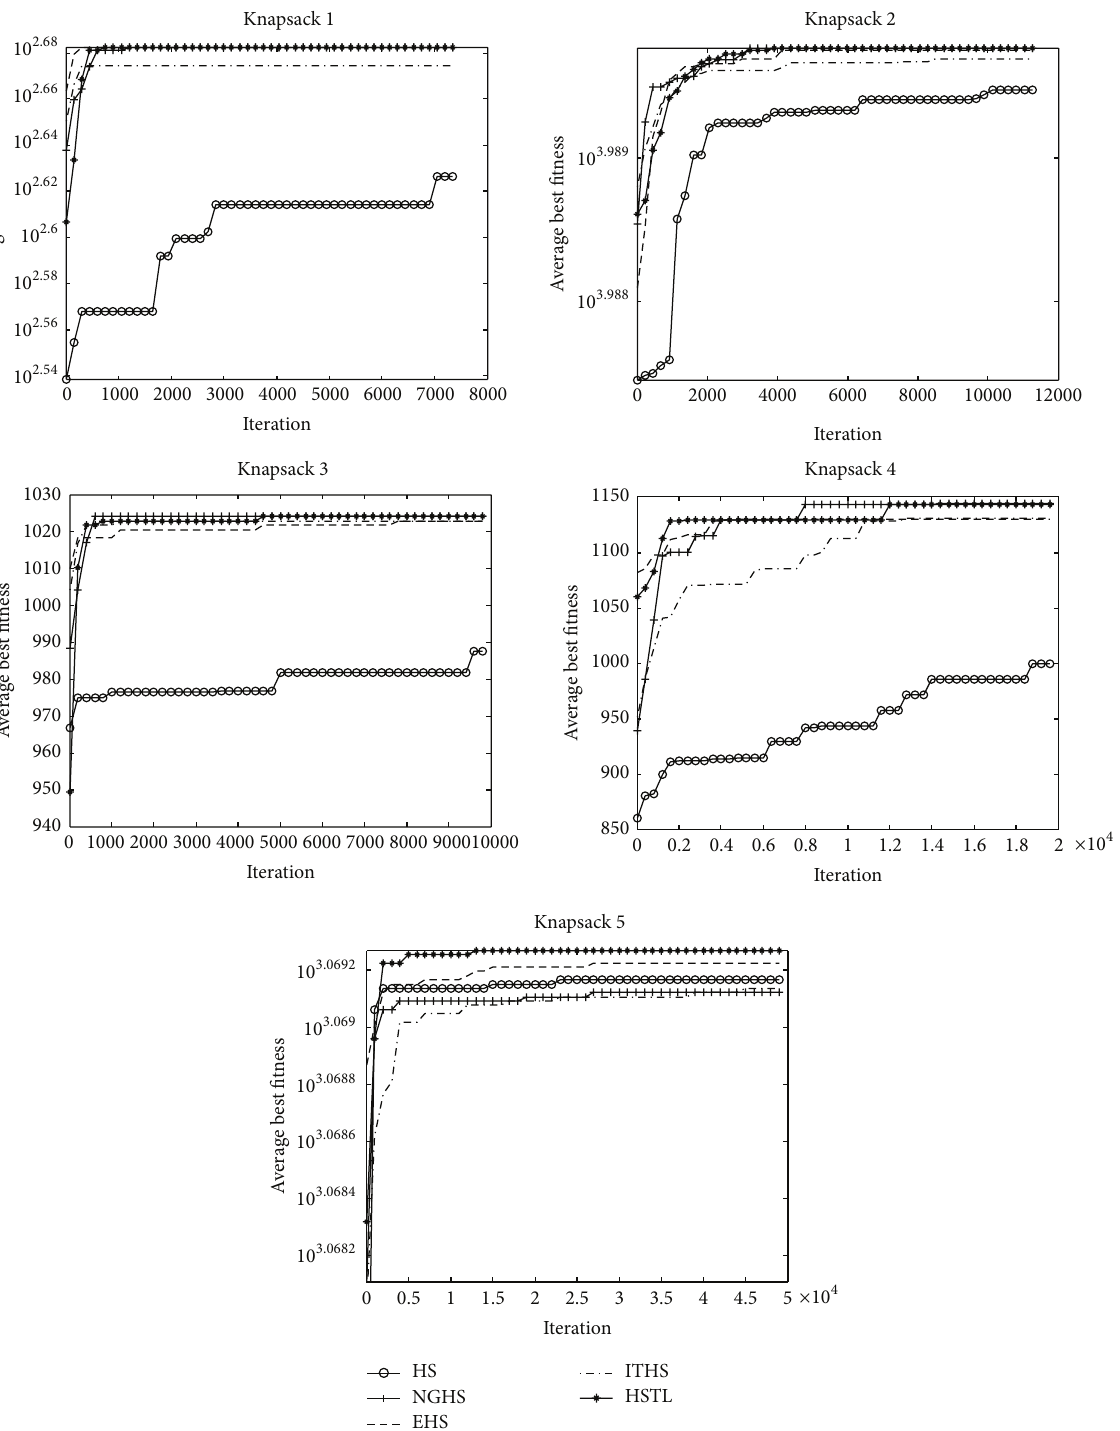
Figure 4: The convergence graphs of KP 1 –KP 5